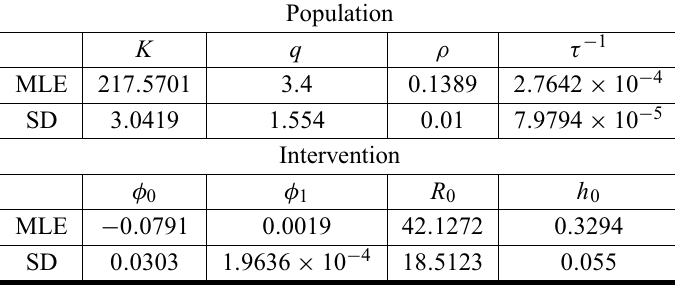
Fig. 2 – Slaughter of the bovine population in Brazil between 1983 and 2008. The MLE and SD estimates of the Richards model